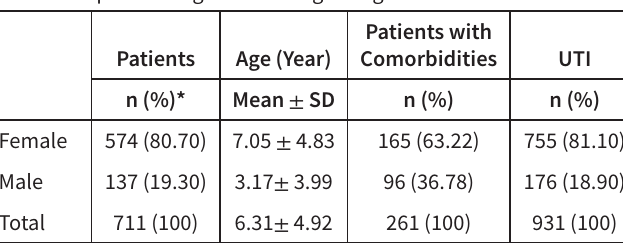
Table 1. Epidemiological Data Regarding Patients with UTIs